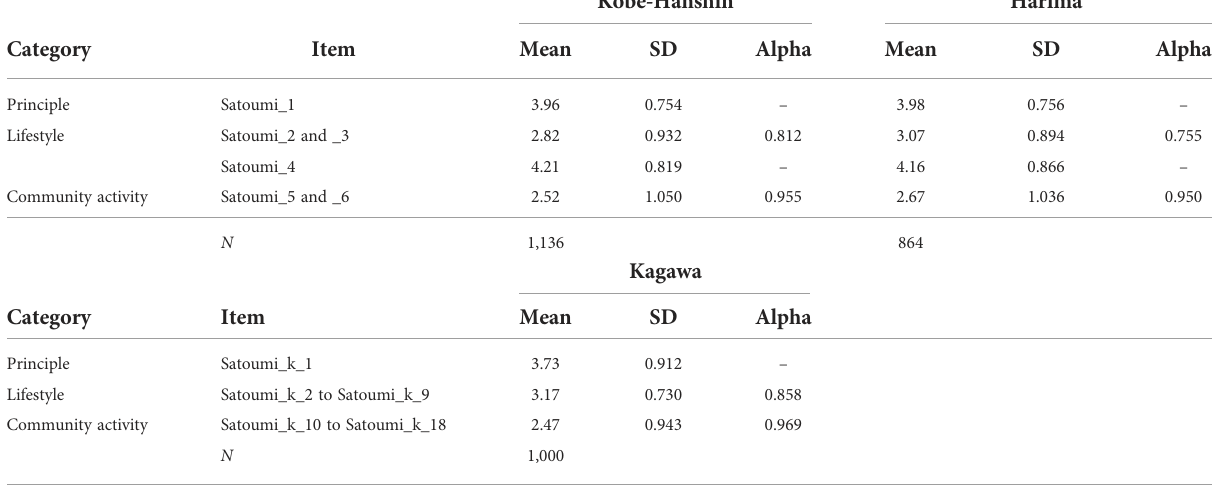
TABLE 7 Characteristics of pro-SES items by